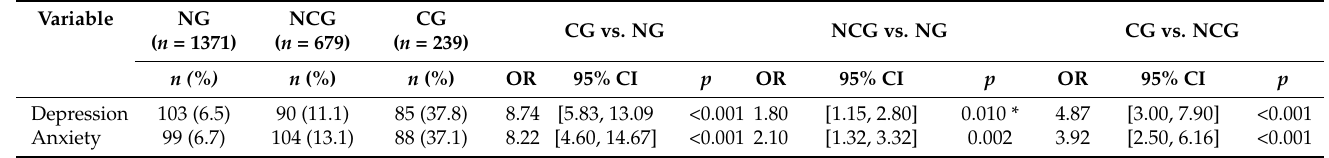
Table 3. Prevalence and odds of the psychological difficulties according to grazing